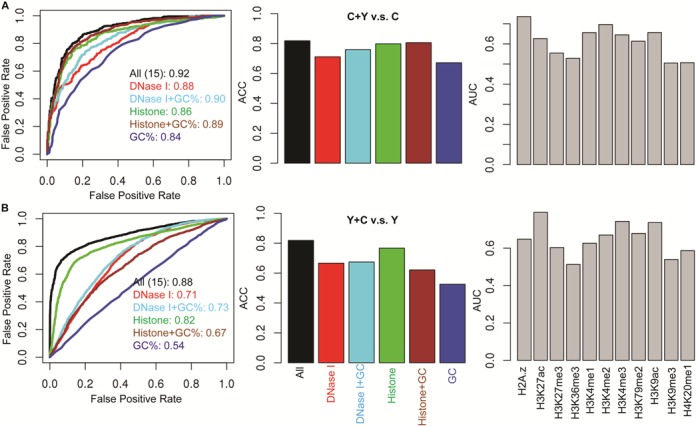
Chromatin features are predictive of CTCF–YY1 co-occupancy from (A) CTCF-only and (B) YY1-only events with high accuracies in the GM12878 cell line. Left: ROC curves are shown with colors representing predictions using different chromatin features and AUC values are indicated in the legend; Middle: predictions evaluated with ACCs; and Right: predictions evaluated with AUC values using individual histone features.